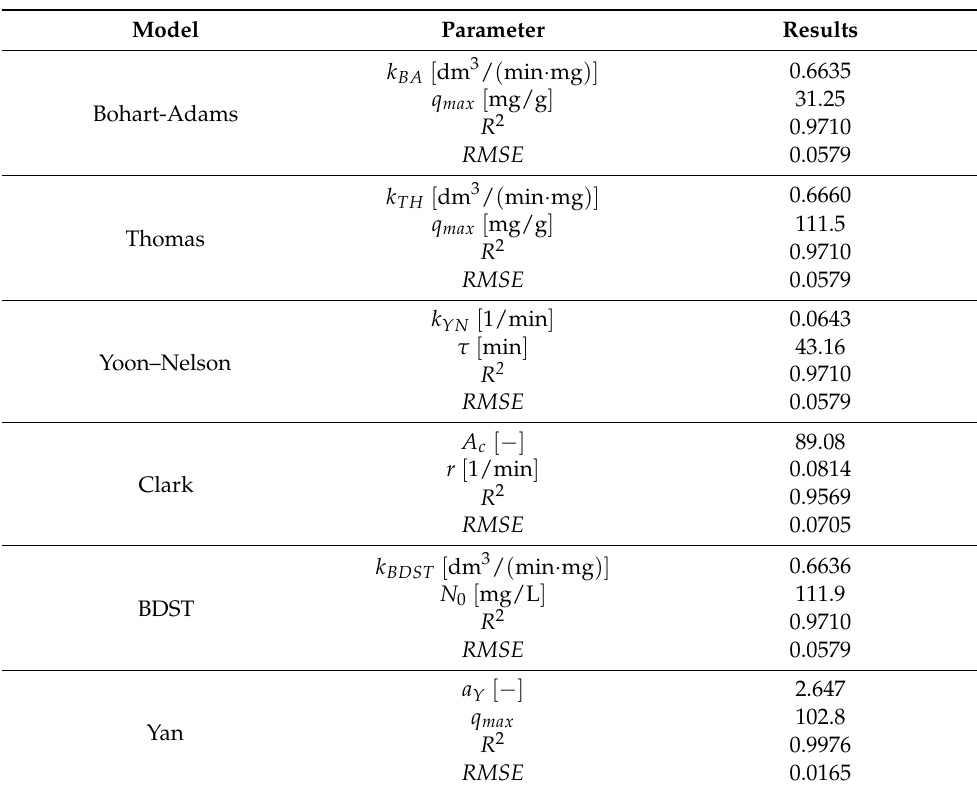
Table 7. Parameters determined for mathematical models describing mercury sorption on a hydrochar bed